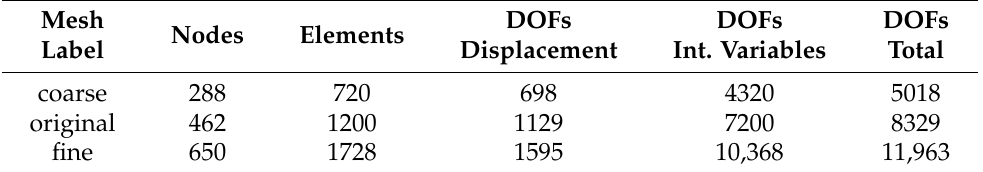
Table A1. Brief characterization of meshes used in the mesh sensitivity inspection.